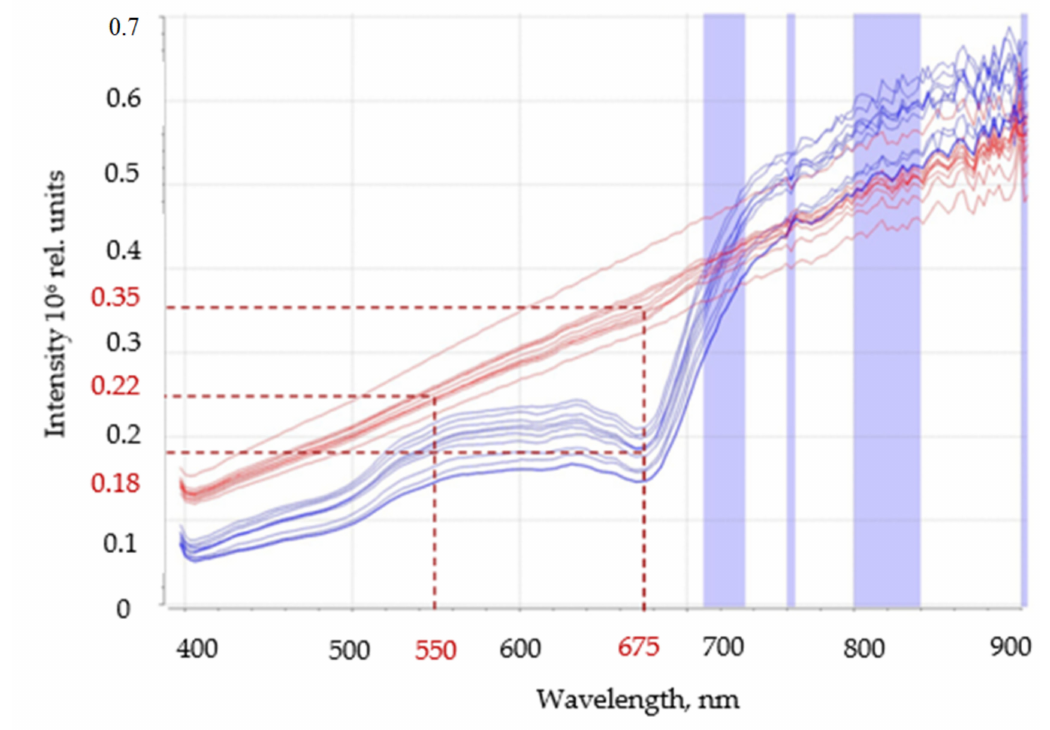
Figure 3. Spectral characteristics of the tested components of the feed